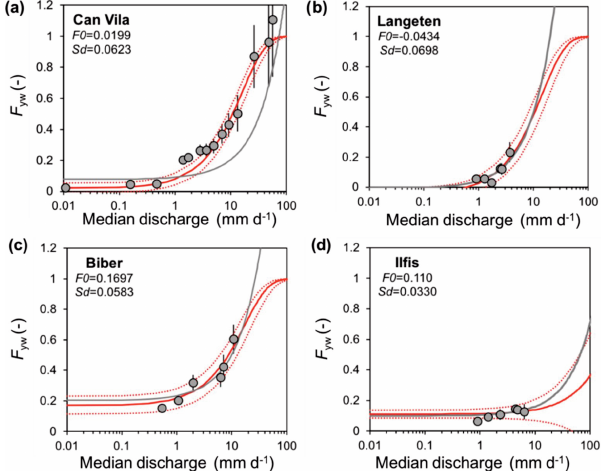
Figure 3. Sensitivity of the young water fraction on discharge for the (a) Can Vila, (b) Langeten, (c) Biber and (d) Ilfis catchments. The red curves represent exponential fits (Eq. 6), with parameters S d and F 0 obtained through volume-weighted non-linear fitting of Eq. (8) to the stream water isotope data; red dashed lines indicate ± 1 standard error. The grey curves represent the linear fit (Eq. 5).